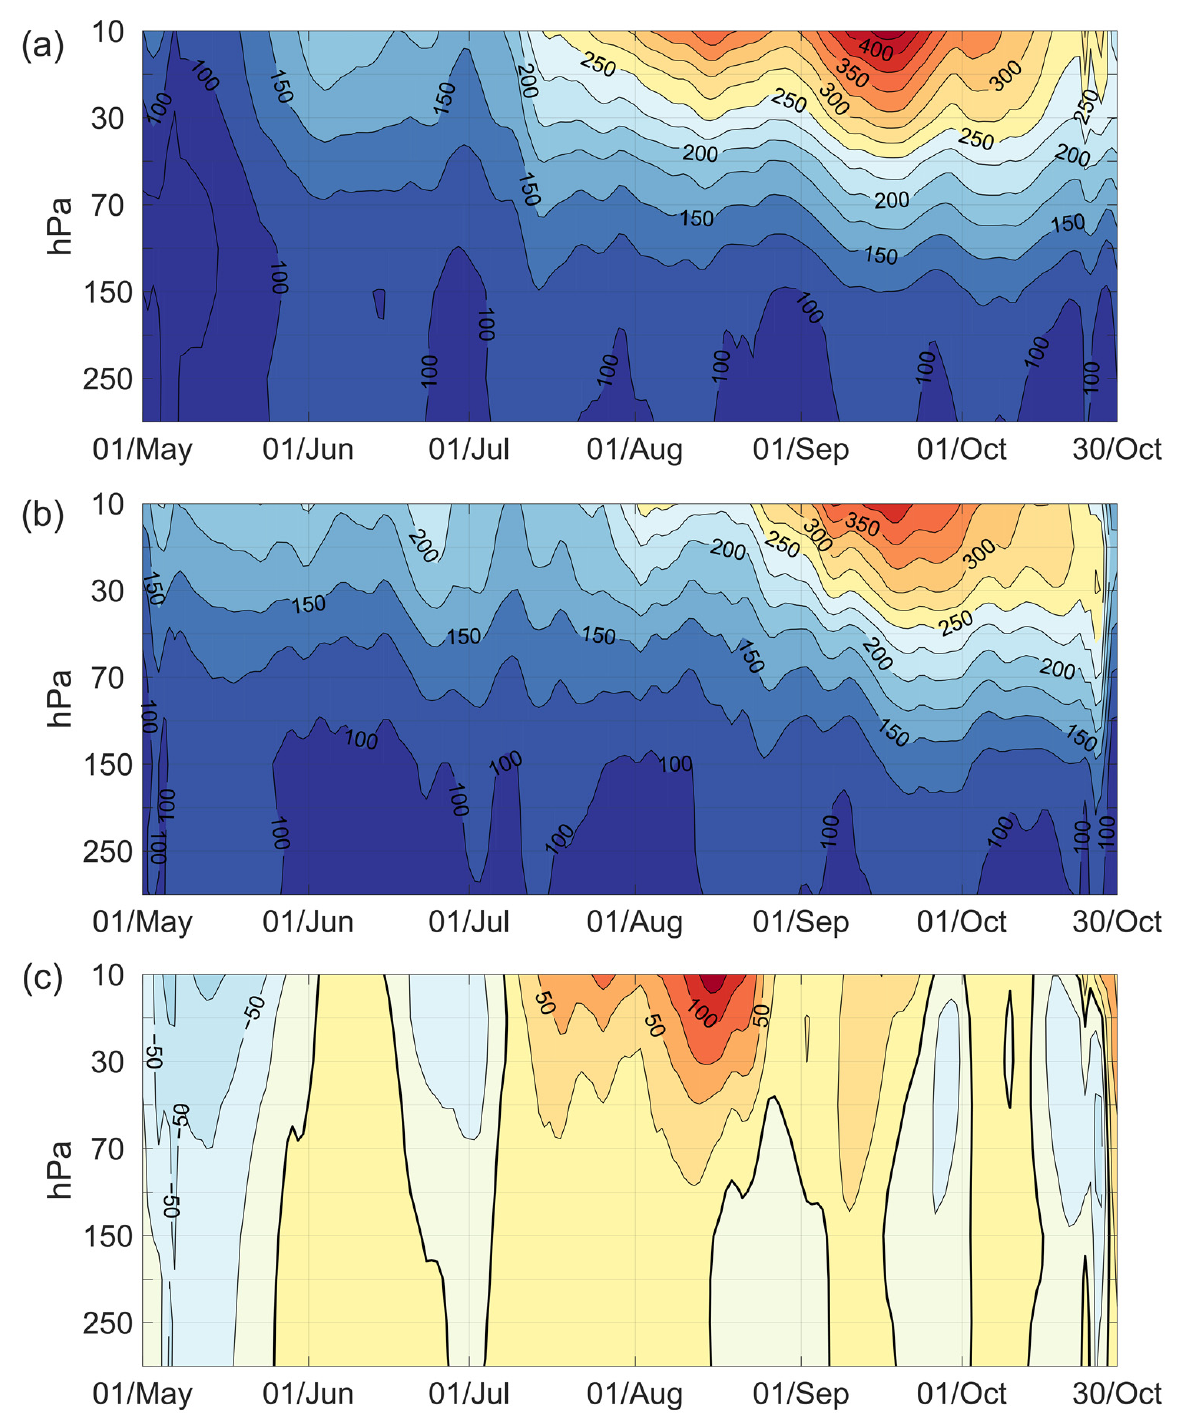
Figure 12. Composite vertical sections of amplitude of wave with zonal wave number 2 averaged between 50 and 70° S for ( a ) Eastern Pacific and ( b ) Central Pacific El Niño events and ( c ) difference between composites of EP and CP El Niño events. Values are smoothed with a 15-day running mean. Contour interval is 25 gpm. Black bold line indicates zero isoline.